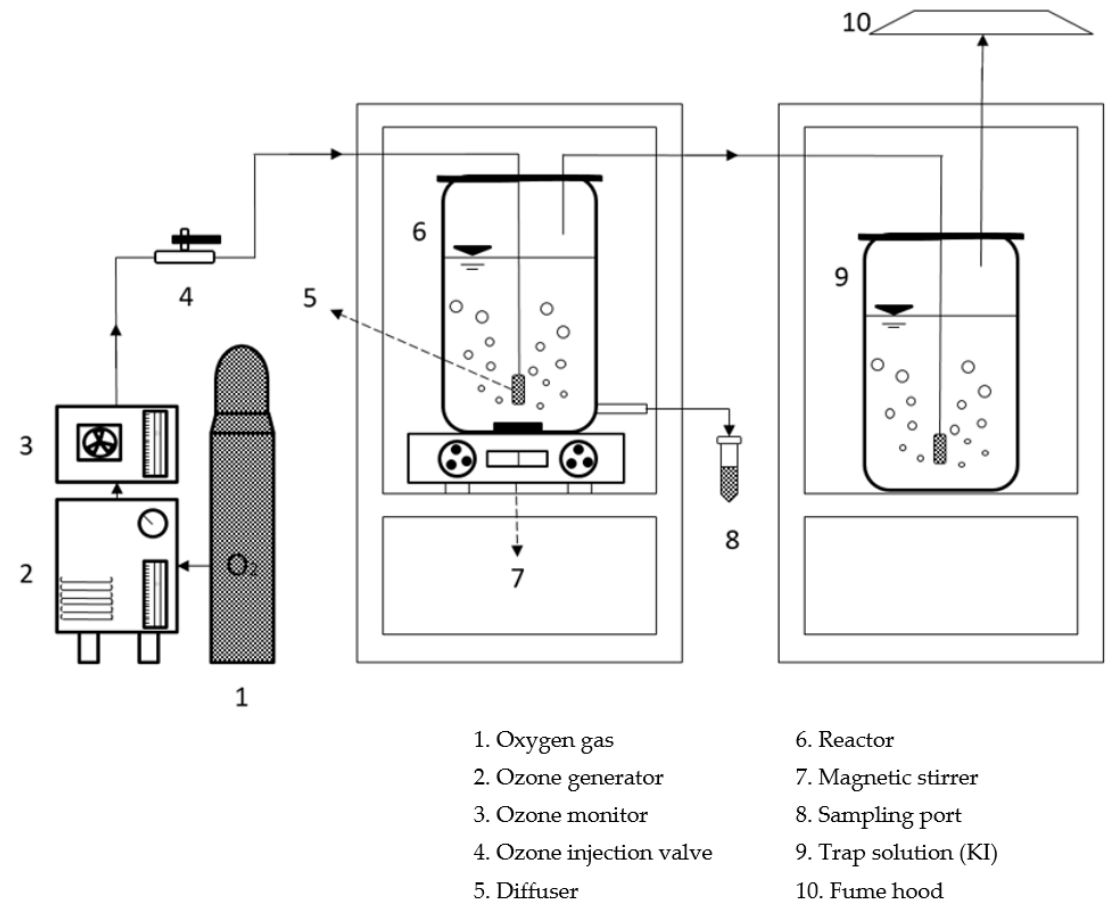
Figure 1. Schematic diagram of the O 3 -oxidation experimental system. Table 2. The experimental conditions for O 3 -oxidation method.